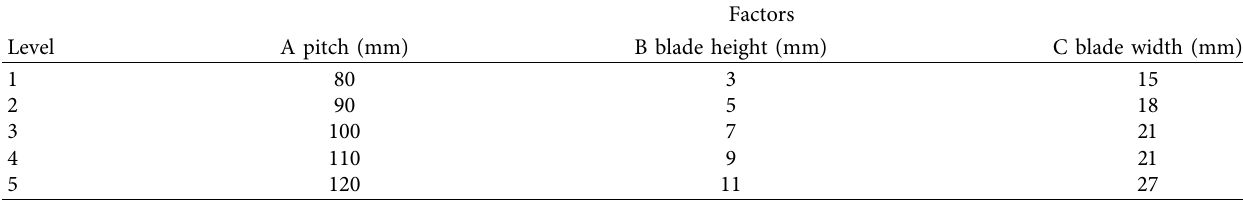
Table 4: Level of simulation factors.